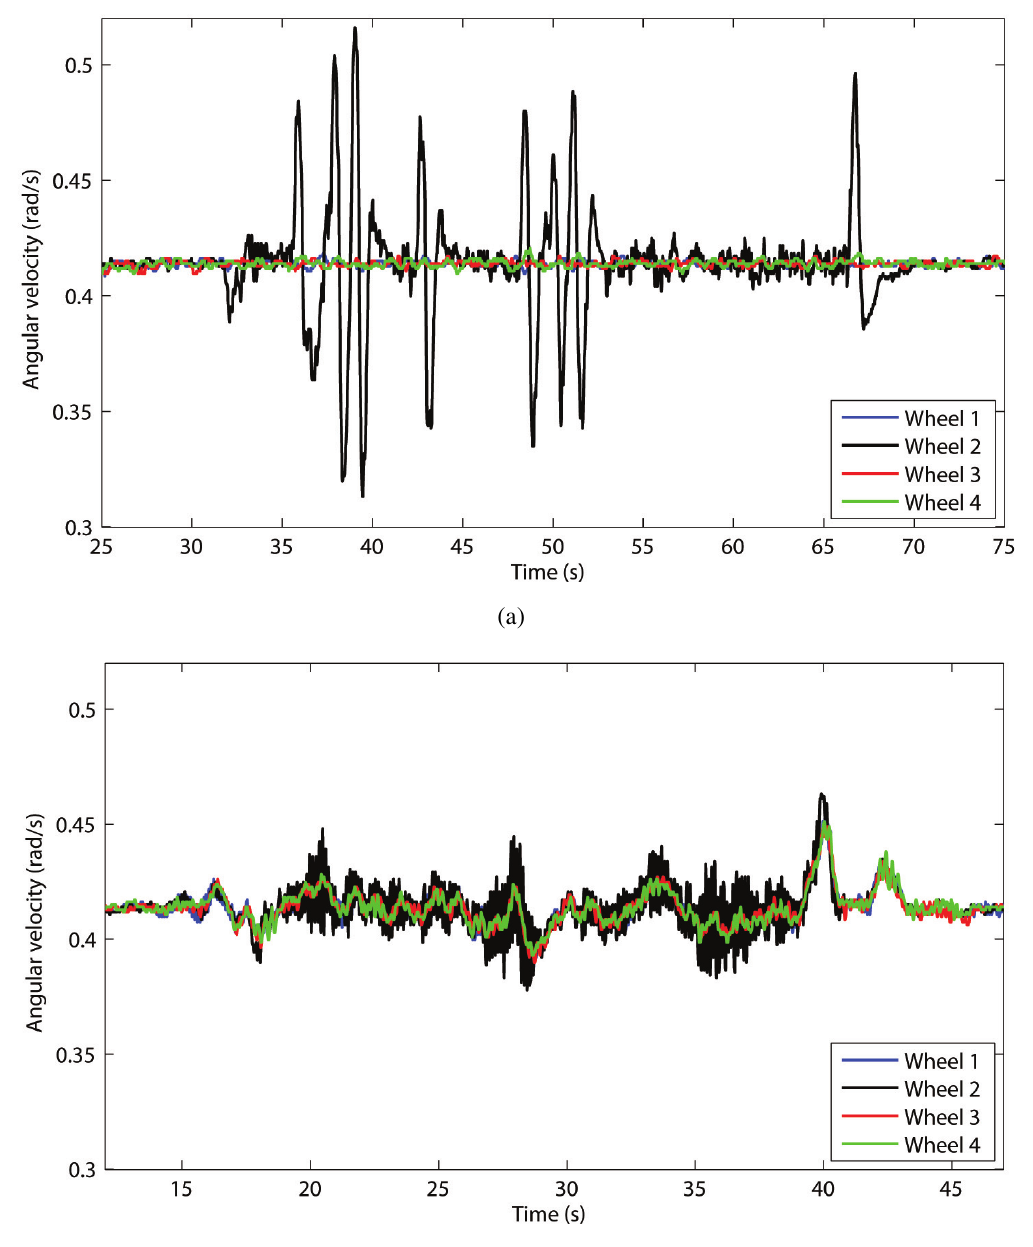
Figure 7. Change in wheel angular velocities in presence of external disturbances applied to Wheel 2. ( a ) Conventional control: The control loops do not share information resulting in Wheel 2 rotating faster or slower than the other wheels. ( b ) Cross-coupled control: By sharing information between the control loops, all wheel velocities are matched more